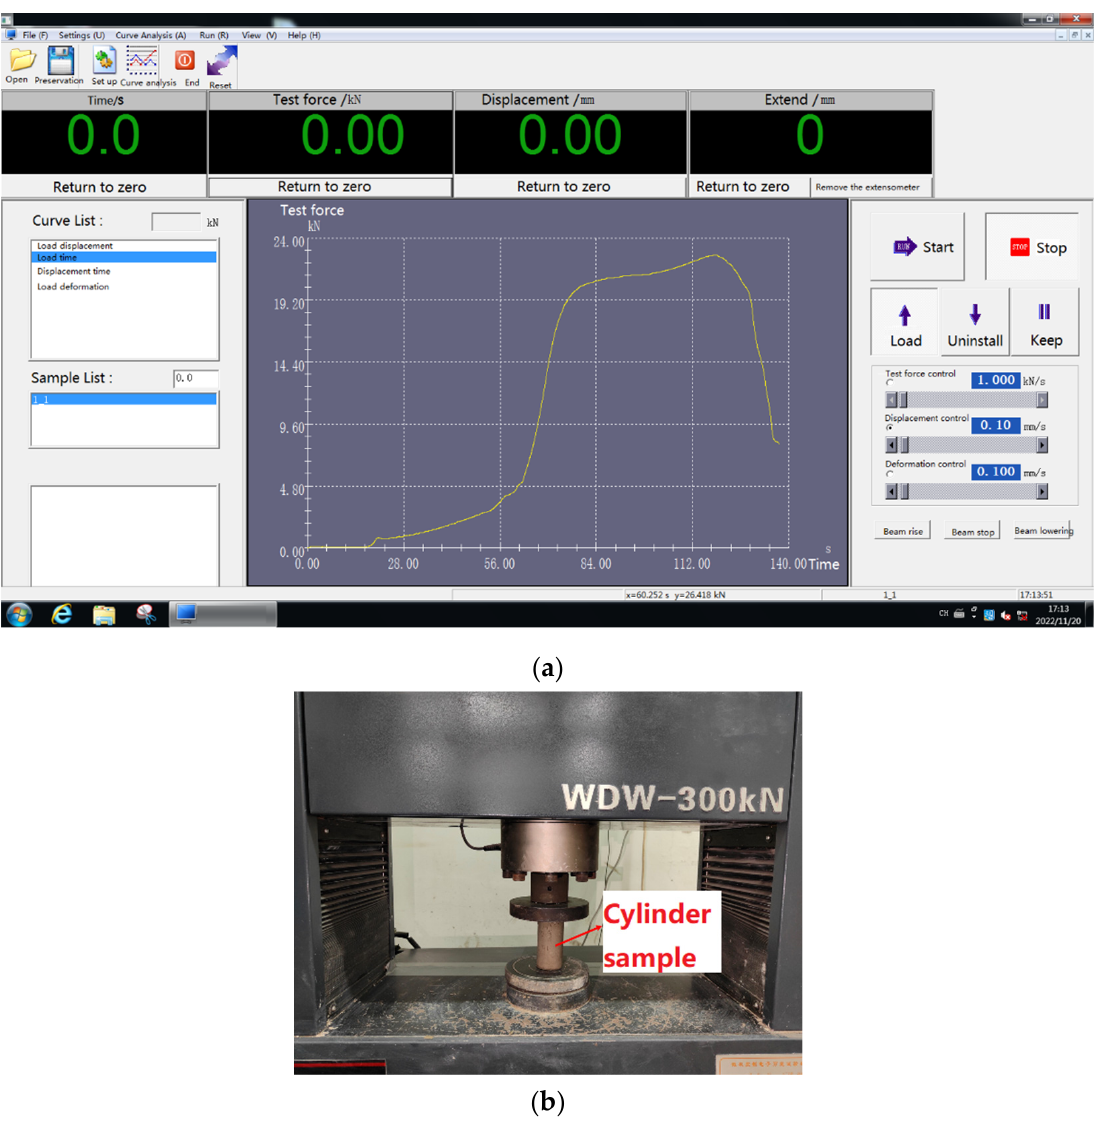
Figure 5. The uniaxial compression test setup: ( a ) test program interface; ( b ) test equipment.